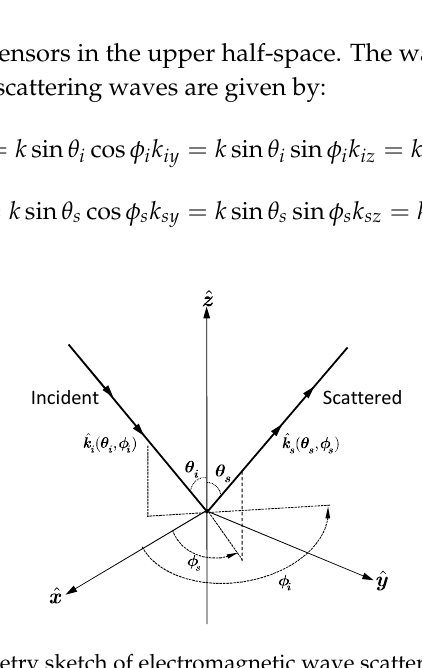
Figure 1. The geometry sketch of electromagnetic wave scattering from sea surface.